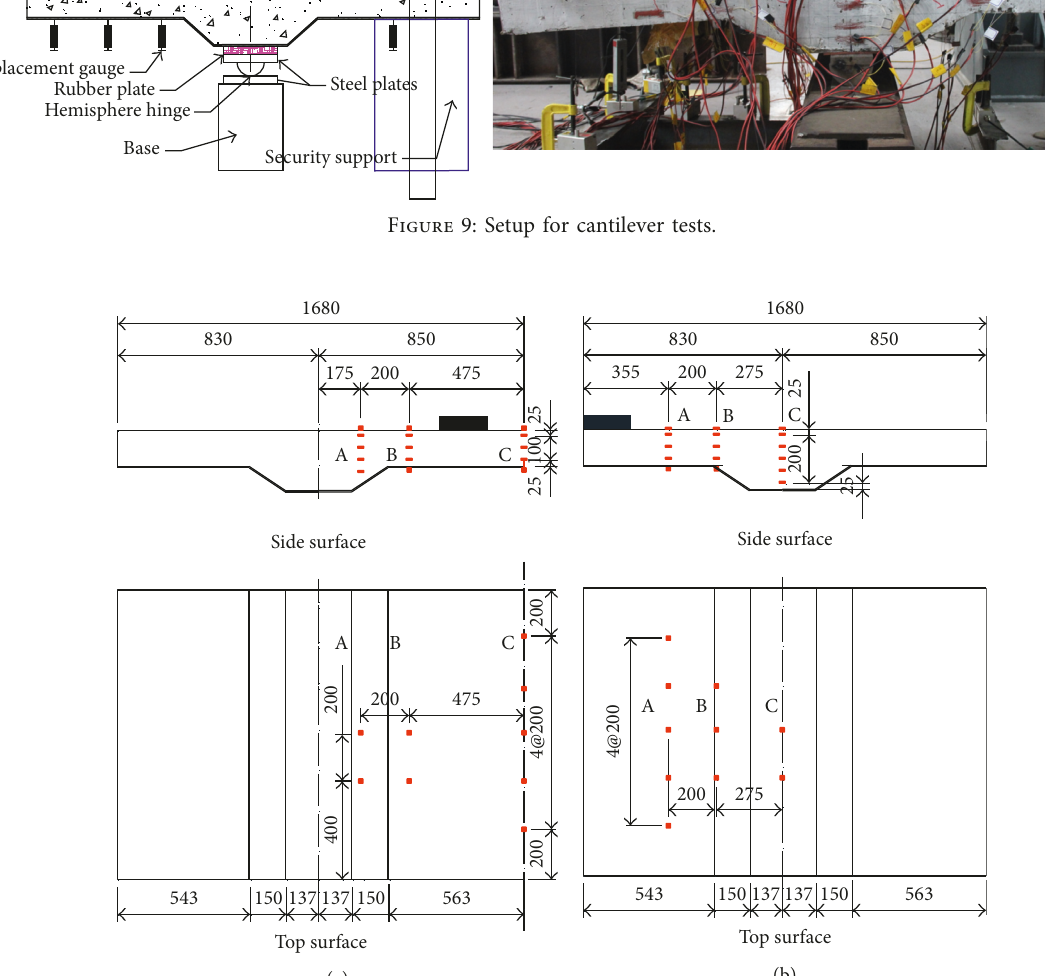
Figure 10: Arrangement of strain gauges on the concrete surface. (a) P1 and P2. (b) N1 and N2.